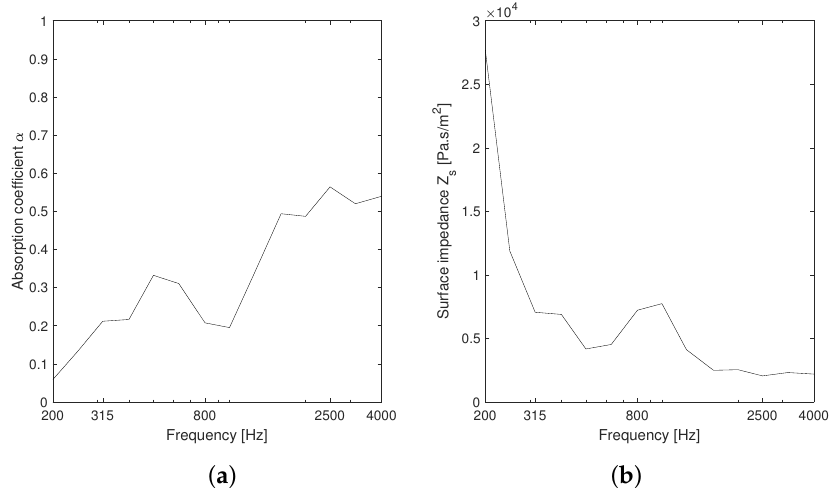
Figure 13. ( a ) Measured absorption coefficient in the diffuse field (adapted from [38]); ( b ) correspond- ing surface impedance used in the calculation model.